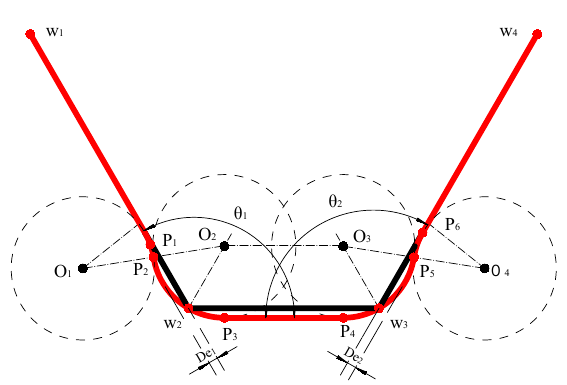
Figure 6. Adaptation to the special case with two close